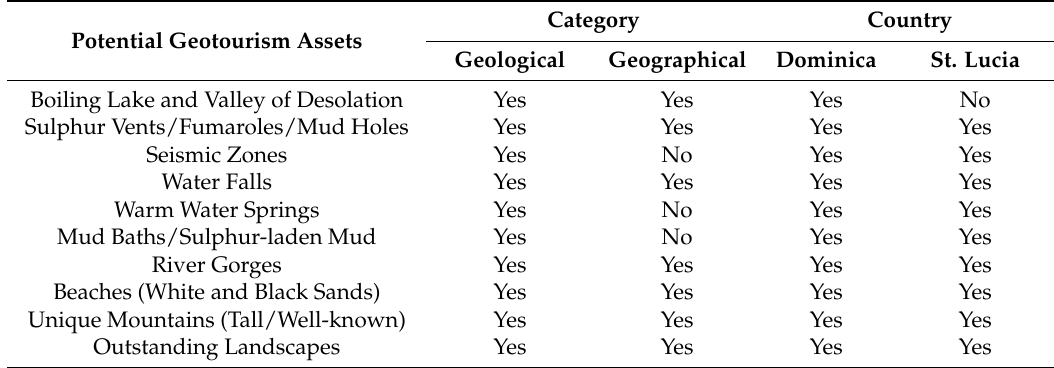
Table 2. Summary of the categorization of the geotourism resources identified in the OECS states of Dominica and St. Lucia, which are examined in this study. Category Potential Geotourism Assets Geological Boiling Lake and Valley of Desolation Yes Yes Yes No Sulphur Vents/Fumaroles/Mud Holes Yes Yes Yes Yes